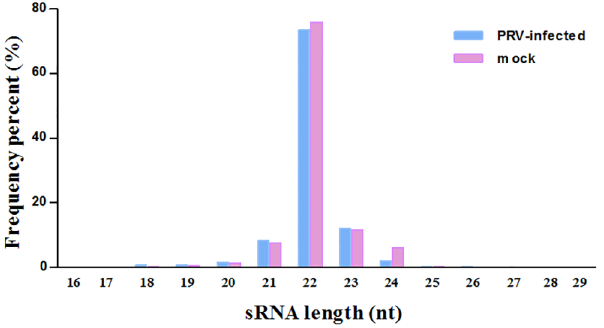
Fig 1. Length distributions of sRNAs (18 – 30 nt) in PRV-infected and uninfected PK15 cells. doi:10.1371/journal.pone.0151546.g001 each sample, 97.81% and 98.75% high quality sRNAs were 20 – 24 nts in length, with most sRNAs 22 nts in length (Fig 1). The sRNAs were categorized and annotated by following the (Table 1). Ultimately, 87,409,488 (78.02%) and 88,667,800 (80.9%) miRNA reads from two libraries were matched to known PRV and host miRNAs sequences, and then 19309634 (17.23%) and 16515597 (15.07%) unannotated sRNA reads from two libraries were matched to PRV and pig genome for predicting novel miRNA.